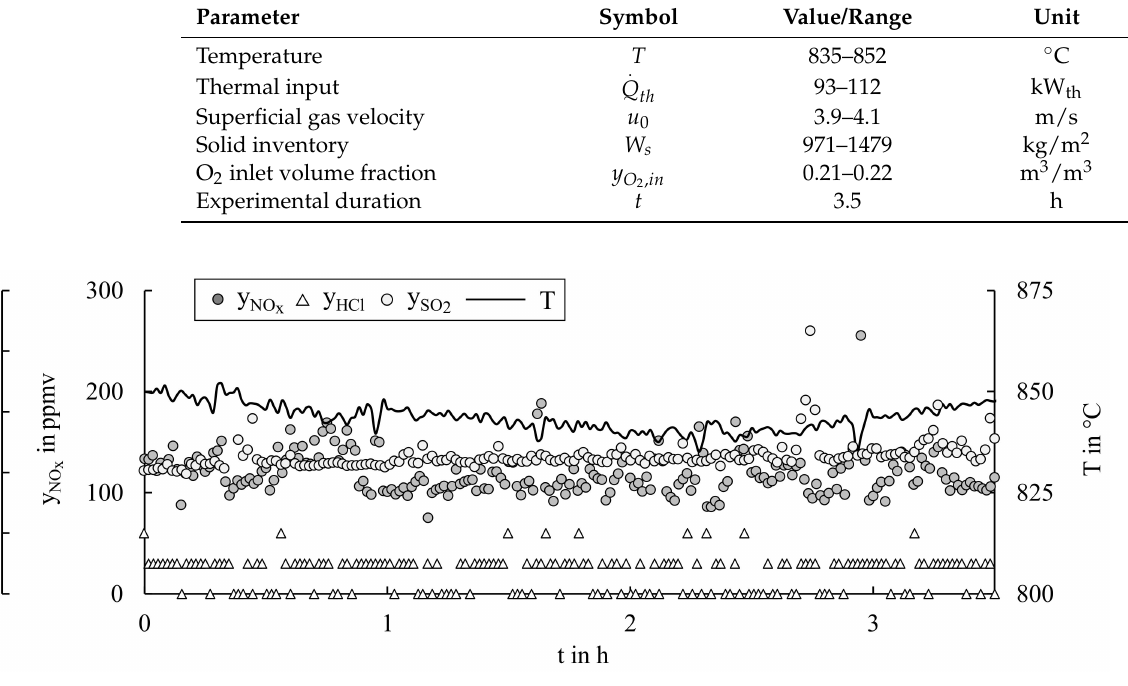
), HCl ( y HCl ), SO 2 ( y SO ), and temperature ( T ) against time ( t ) during solid x 2 and y SO were measured by non-dispersive infrared spectroscopy; y HCl was x 2